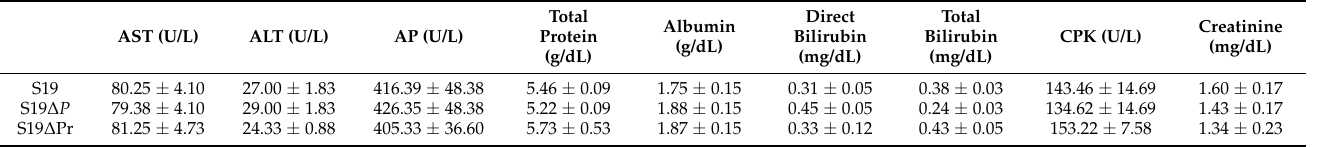
Table 1. Serum biochemical profiles in immunized buffaloes on 14 days post immunization. AST (U/L)